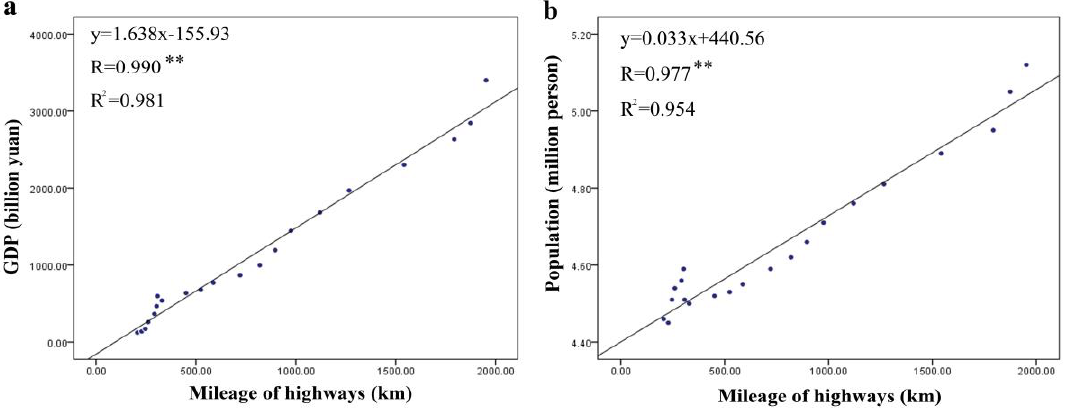
Figure 9. Linear regression between socio-economic indicators and mileage of expressway for ( a ) GDP and ( b ) population.